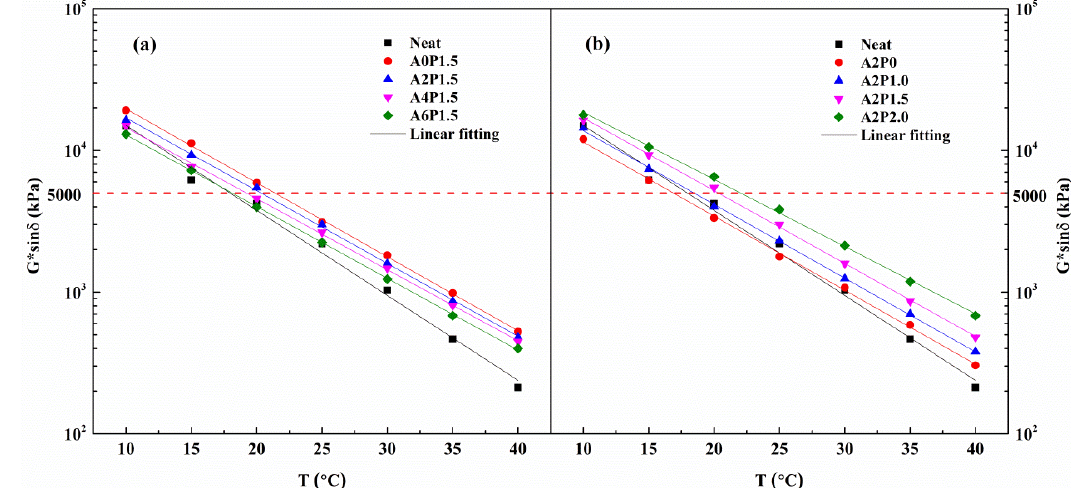
Figure 14. G *sin δ variations with temperature for composite modified binders: ( a ) composite modified binders with various contents of APAO; ( b ) composite modified binders with various contents of PPA.